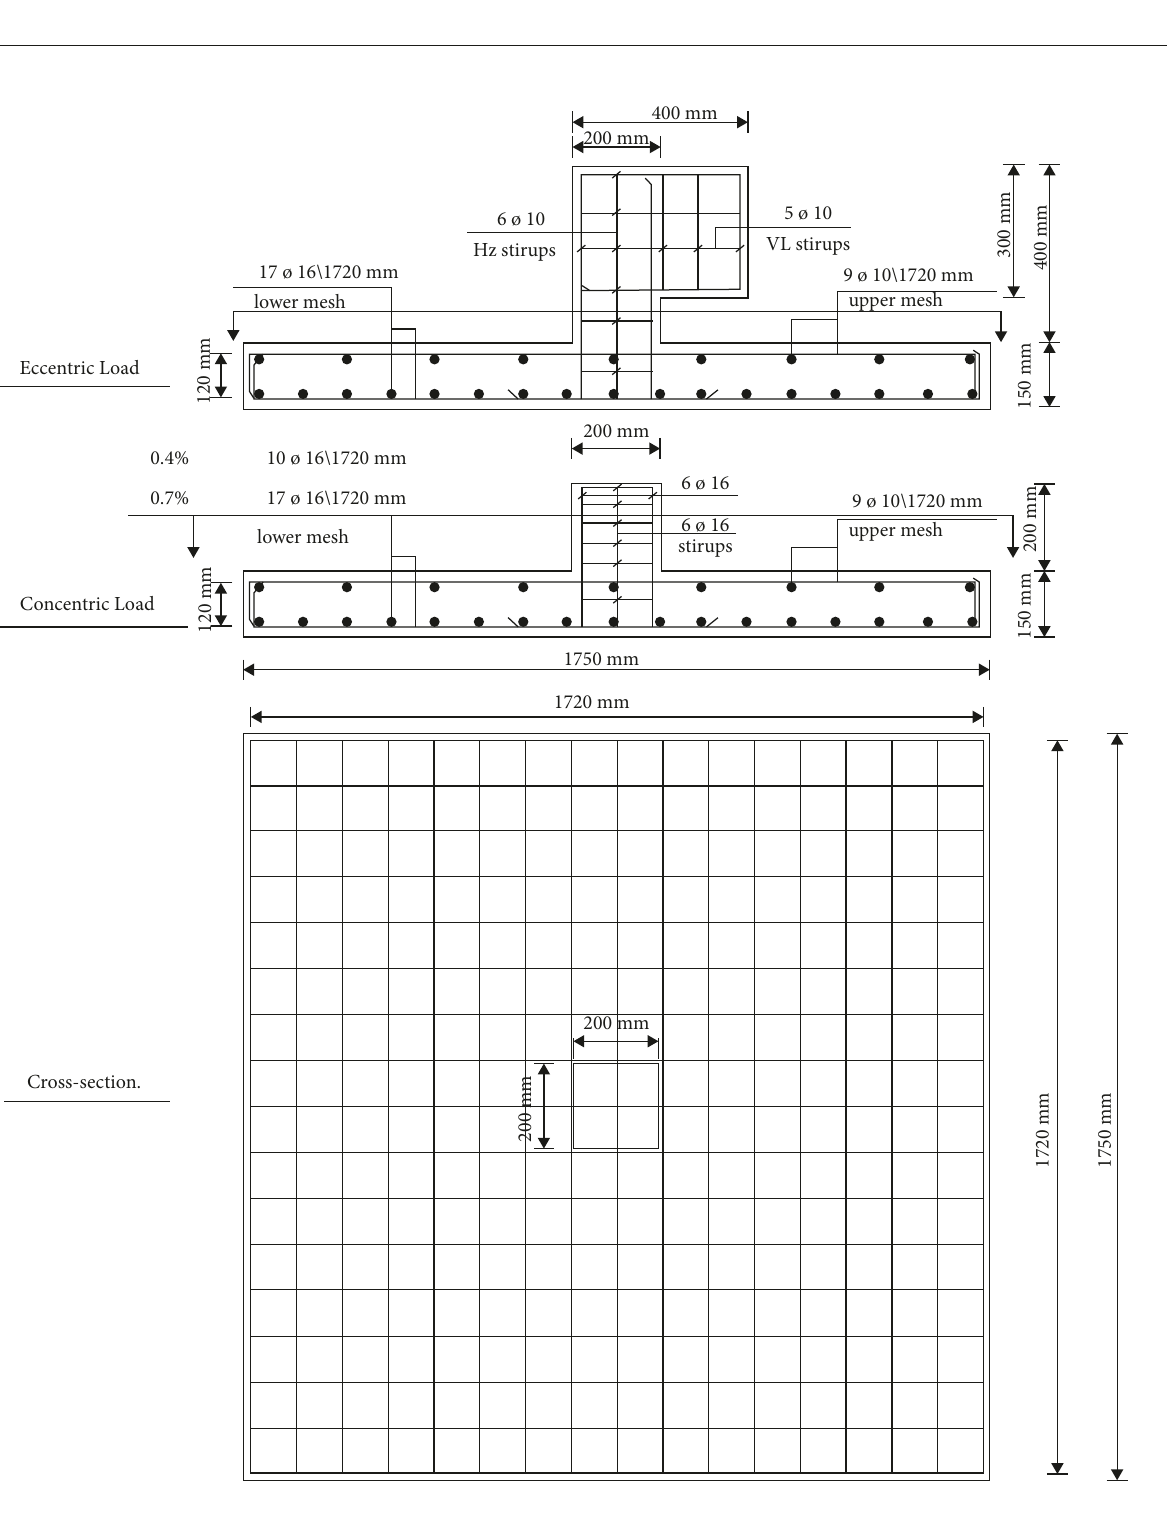
Figure 1: Typical dimensions and RFT for tested